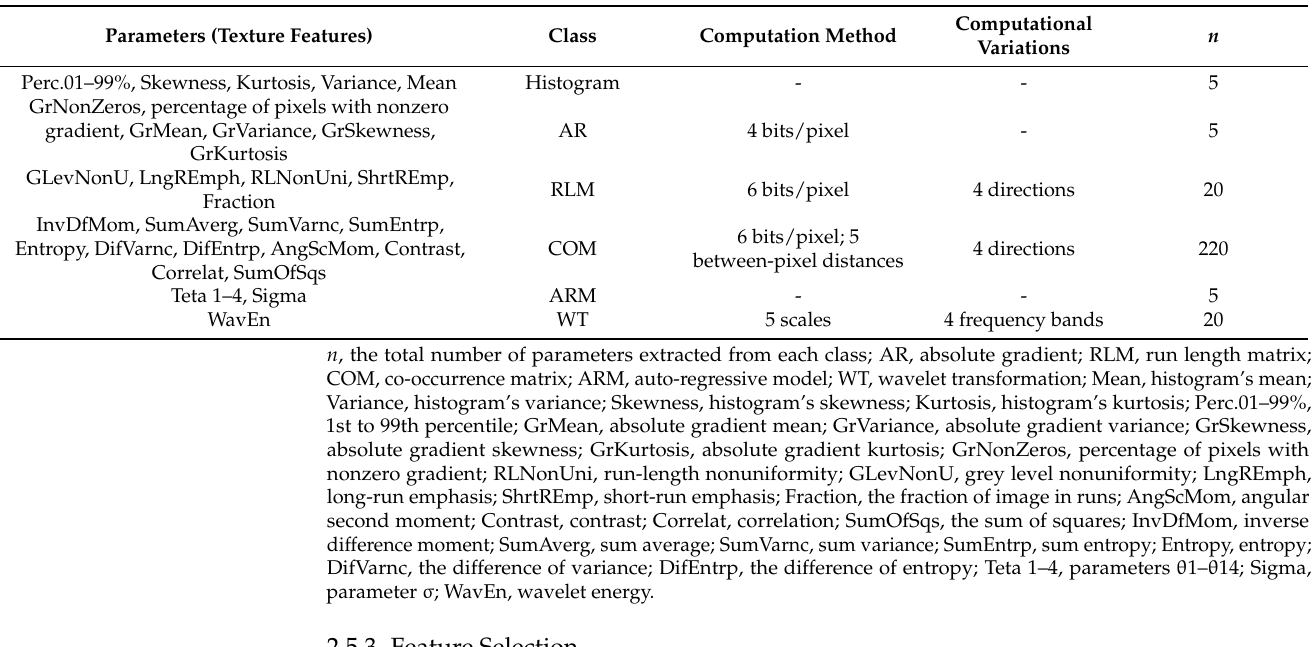
Table 1. Texture